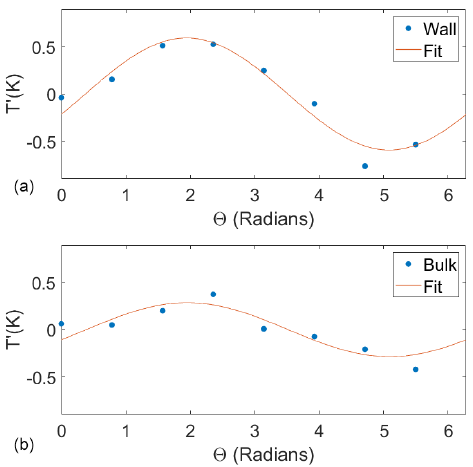
Figure 6. An example of the sinusoidal fit to the temperature fluc- tuations ( T (cid:48) ) with respect to the azimuthal position of the RTDs ( (cid:50) ) along the wall (a) and in the bulk (b) . The uncertainty in the tem- perature is too small to be seen on the graph. The goodness of the fit does not change over time.